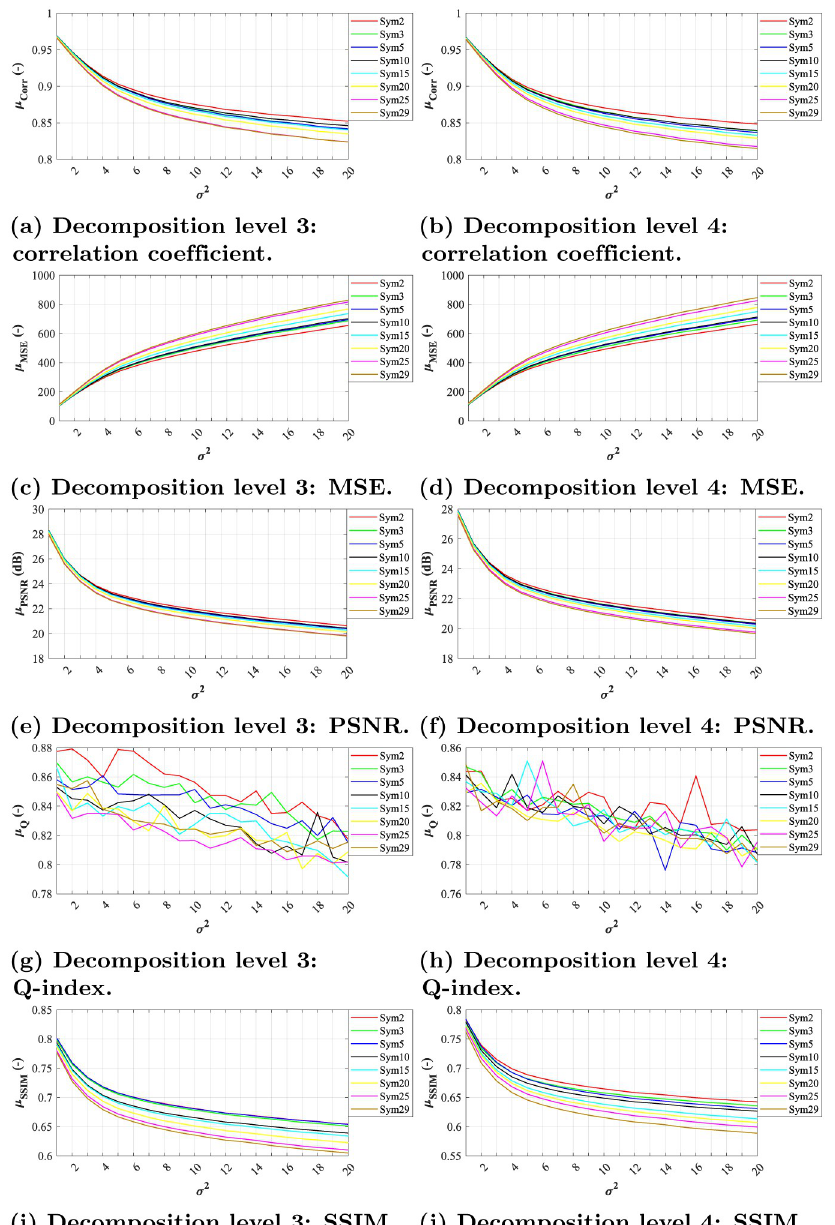
coefficient. (c) Decomposition level 3: MSE. (d) Decomposition level 4: MSE. (e) Decomposition level 3: PSNR. (f) Decomposition level 4: PSNR. (g) Decomposition level 3: Q-index. (h) Decomposition level 4: Q-index. (i) Decomposition level 3: SSIM. (j) Decomposition level 4: